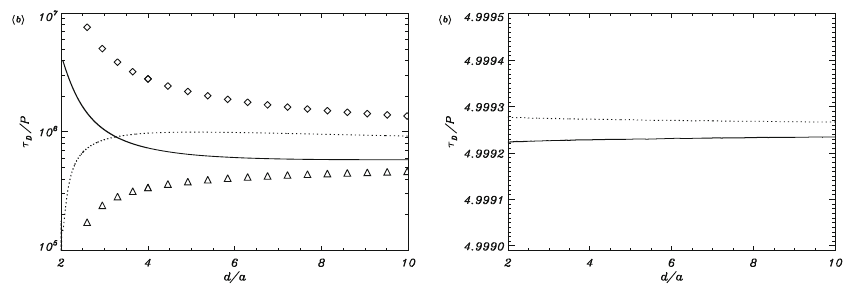
Fig. 64 Wave damping by thermal effects in a two-thread system. Left: ratio of the damping time to the period versus the distance between the thread axes of the S x (solid line), A x (dotted line), S y (triangles) and A y (diamonds) kink-like modes. Right: the same for the S z (solid line) and A z (dotted line) slow wave modes. Image reproduced with permission from Soler et al. (2009c), copyright by